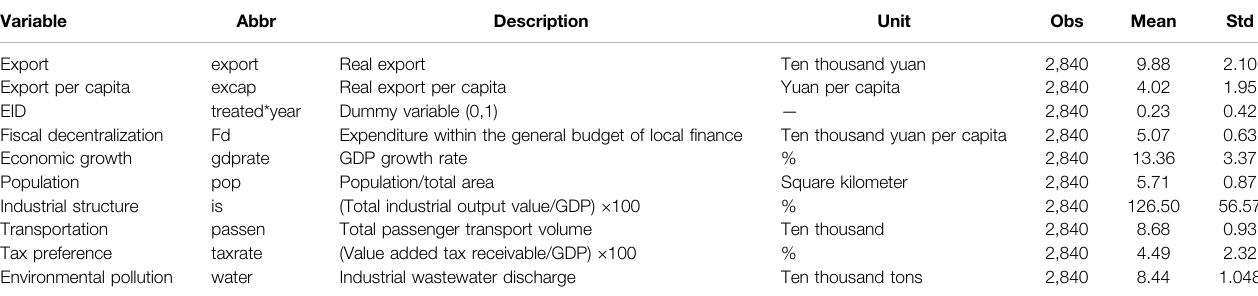
TABLE 1 | Statistical description.